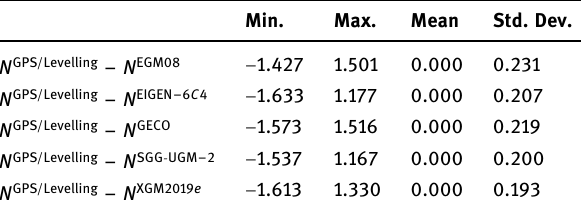
Table 4: Statistics of the di ff erences between the GPS/levelling - derived geoid undulations and those computed from the di ff erent GGMs - HR after the four - parameter transformation model has been applied in meters Min. Max. Mean Std. Dev.